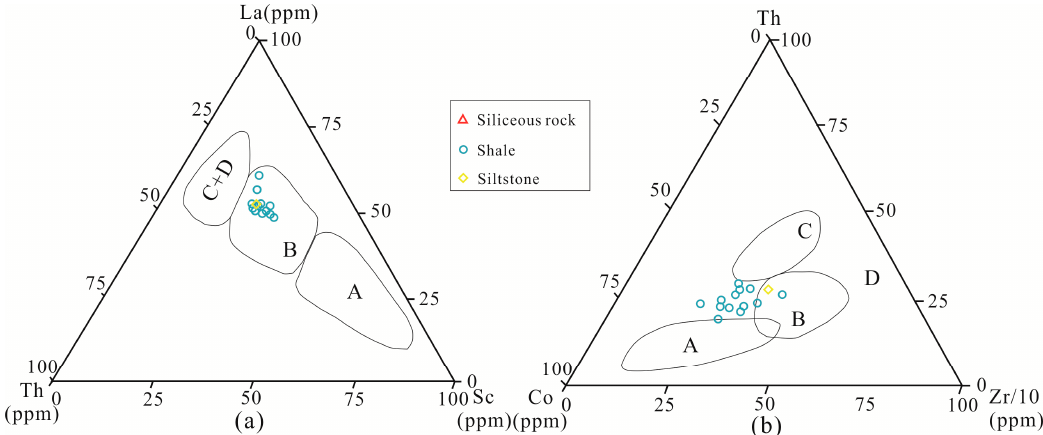
Figure 12. Tectonic setting discrimination diagrams of ( a ) La-Th-Sc and ( b ) Th-Co-Zr/10 for the samples from CY-1. A: Oceanic island arc; B: Continental island arc; C: Active continental margin; D: Passive continental margin. Base map from [35].